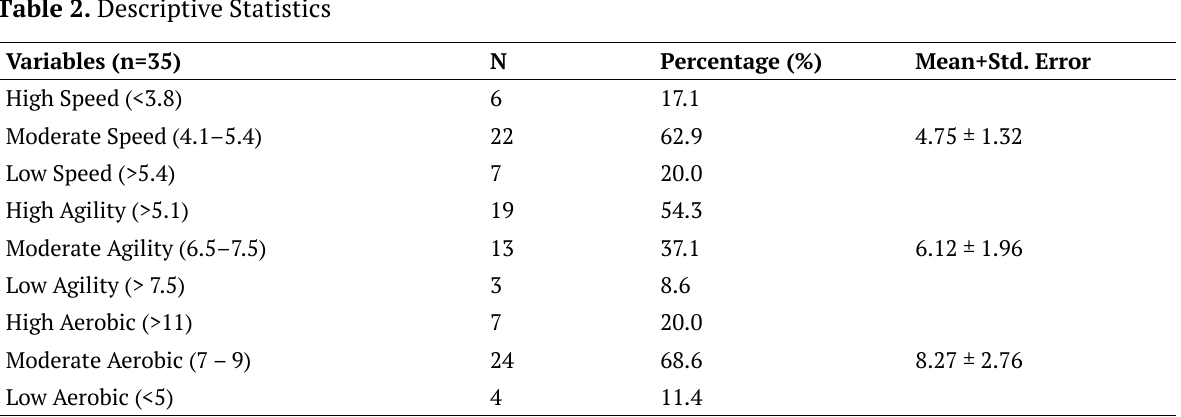
Table 2. Descriptive